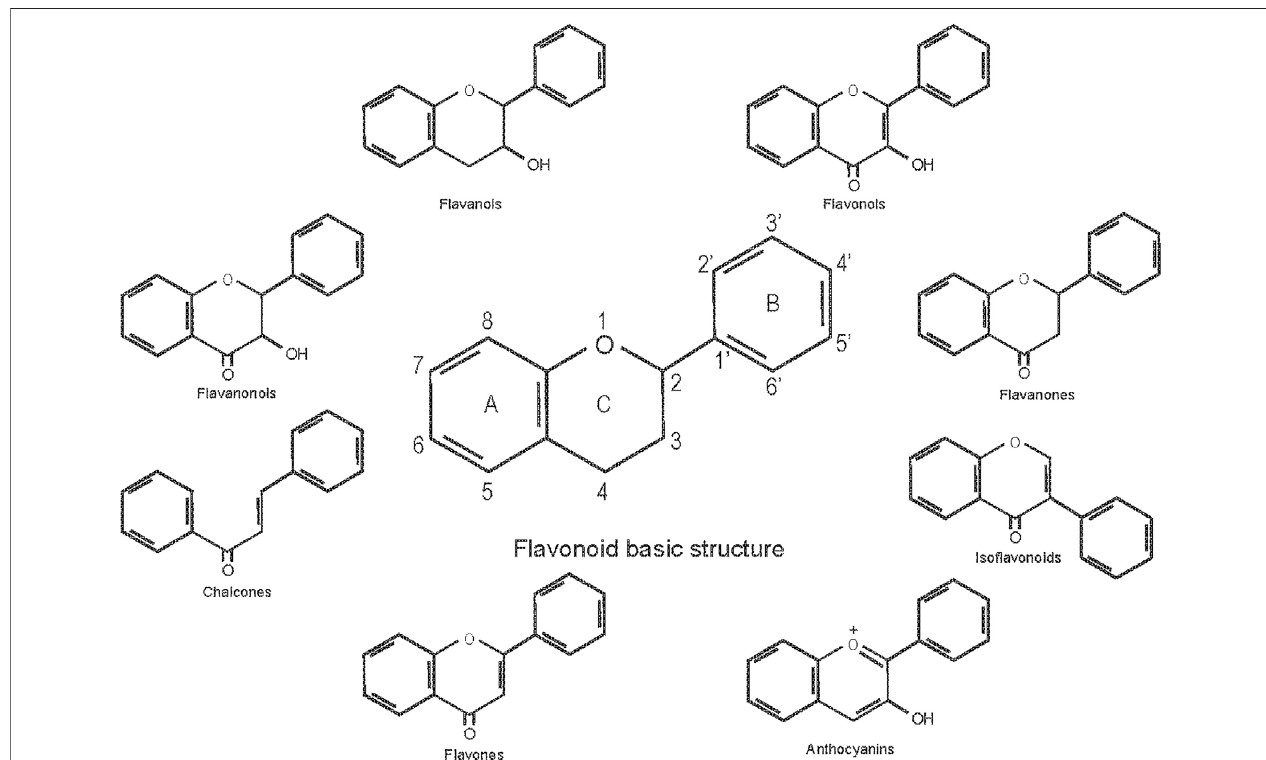
FIGURE 1 | Classi fi cation of fl avonoids and their basic